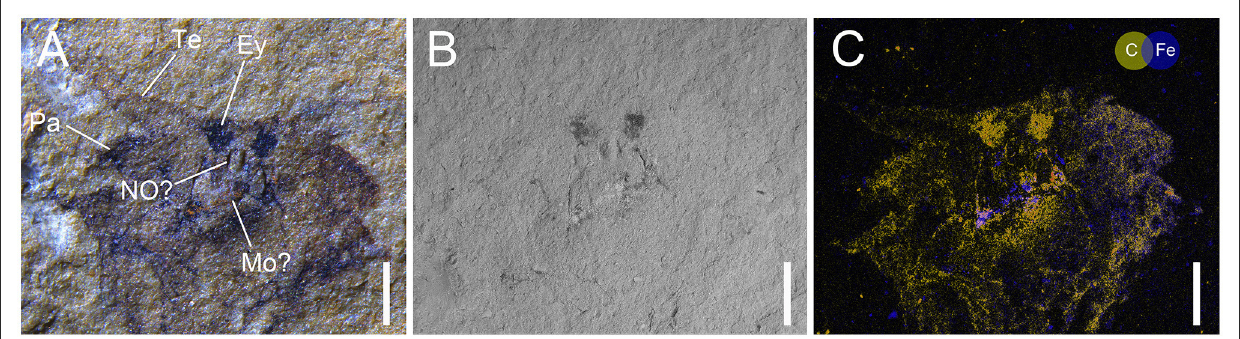
FIGURE3 Gaoloufangchaeta bifurcus gen. et sp. nov. (A) detail of Figure 2, position marked by frame a. (B, C) SEM-EDX maps of (A) , the specimen was rotated slightly to the left. Ey, eye; Mo?, possible mouth; NO?, possible nuchal organ; Pa, parapodium; Te, tentacle. The scale bars are 0.5mm.